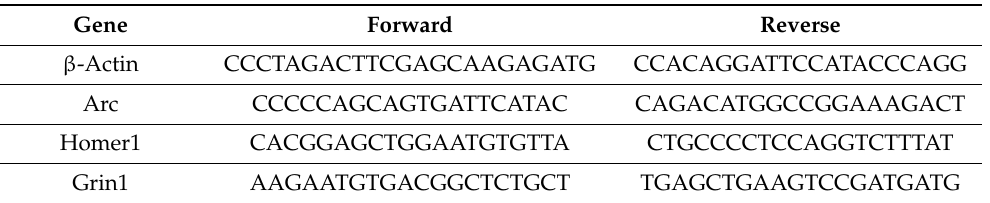
Table 1. Primers used in the qPCR